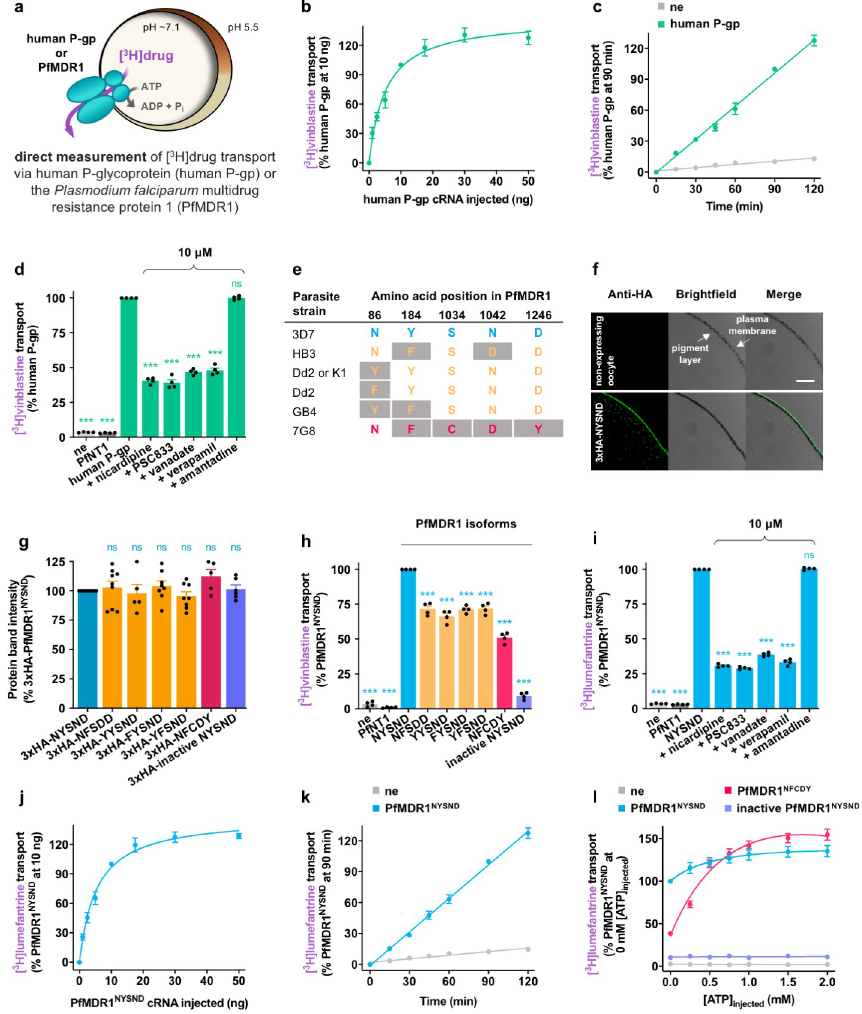
Fig 1. Heterologous expression of functional human P-gp and PfMDR1 in Xenopus oocytes. (a) Schematic showing the transport of a [ 3 H]drug via human P-gp or PfMDR1 in the Xenopus oocyte system. (b) The relationship between the quantity of human P-gp cRNA injected into the oocyte and the level of human P-gp–mediated [ 3 H]vinblastine transport measured. (c) The transport of [ 3 H]vinblastine via human P-gp was approximately linear with time for at least 2 hours. (d) The human P-gp–mediated efflux of [ 3 H]vinblastine from oocytes was reduced by known inhibitors of the transporter (nicardipine, PSC8333, vanadate, and verapamil) and was unaffected by amantadine (a drug that does not interact with human P-gp). (e) The field isoforms of PfMDR1 characterized in this study. Residues that differ from the wild-type amino acid sequence are shaded gray. (f) Immunofluorescence microscopy images confirmed that PfMDR1 localized to the oocyte plasma membrane. The expression of 3xHA-tagged PfMDR1 NYSND resulted in a fluorescent band external to the pigment layer, indicating that the protein was expressed at the oocyte surface. The band was not present in ne. The length of the scale bar is 50 μ m. Images showing the presence of the other HA-tagged PfMDR1 isoforms at the oocyte surface are shown in S4 Fig. (g) Semiquantification of PfMDR1 protein levels in the membranes of oocytes expressing different 3xHA-PfMDR1 isoforms indicated that the 7 isoforms were expressed at similar levels. (h) The transport of [ 3 H]vinblastine via PfMDR1. (i) The efflux of [ 3 H]lumefantrine from oocytes expressing PfMDR1 NYSND was reduced by nicardipine, PSC8333, vanadate, and verapamil and was unaffected by amantadine. (j) The relationship between the quantity of PfMDR1 NYSND cRNA microinjected into the oocyte and the level of PfMDR1 NYSND -mediated [ 3 H]lumefantrine transport measured. (k) The transport of [ 3 H]lumefantrine via PfMDR1 NYSND was approximately linear with time for at least 2 hours. (l) Microinjection of additional ATP into the oocyte greatly stimulated [ 3 H]lumefantrine transport via PfMDR1 NFCDY . The data are the mean of n = 4 to 9 independent experiments, each yielding similar results and overlaid as individual data points in panels d , g , h , and i , and the error is the SEM. Where not visible, the error bars fall within the symbols. The asterisks denote a significant difference from human P-gp (panel d ), 3xHA-PfMDR1 NYSND (panel g ), or PfMDR1 NYSND (panels h and i ); ��� P < 0.001, ns, not significant (1-way ANOVA). The data underlying this figure is supplied in S3 Data. ne, nonexpressing oocytes; PfMDR1, Plasmodium falciparum multidrug resistance protein 1; P-gp,